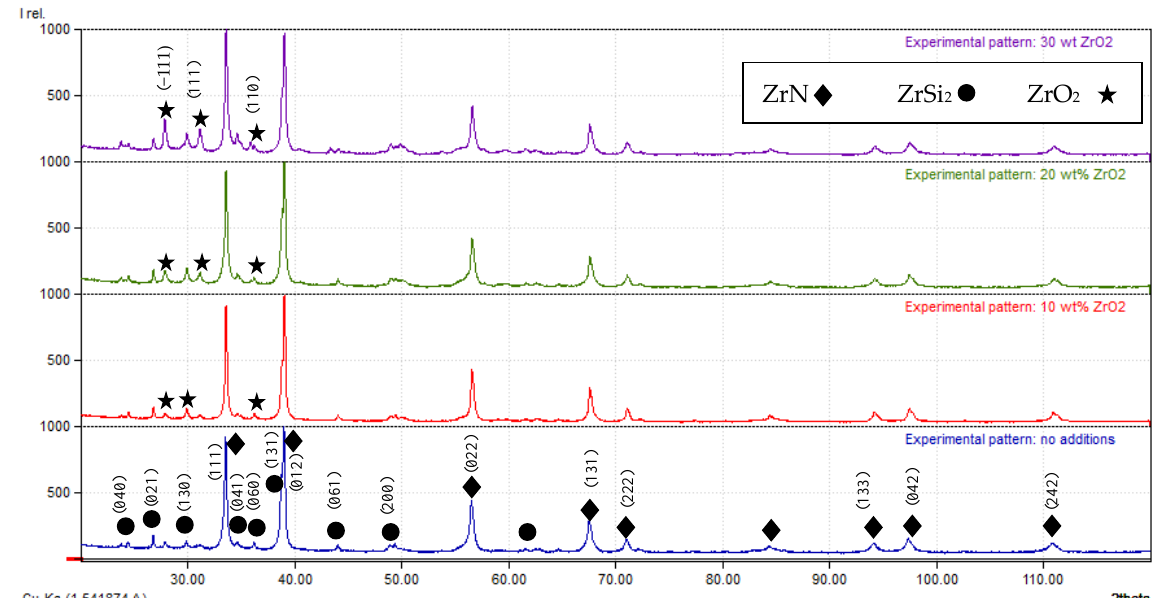
Figure 3. XRD diagrams of the combustion products having different wt% of ZrO 2 prepared at 234 MPa. Porosity and density measurements of the samples containing different ZrO 2